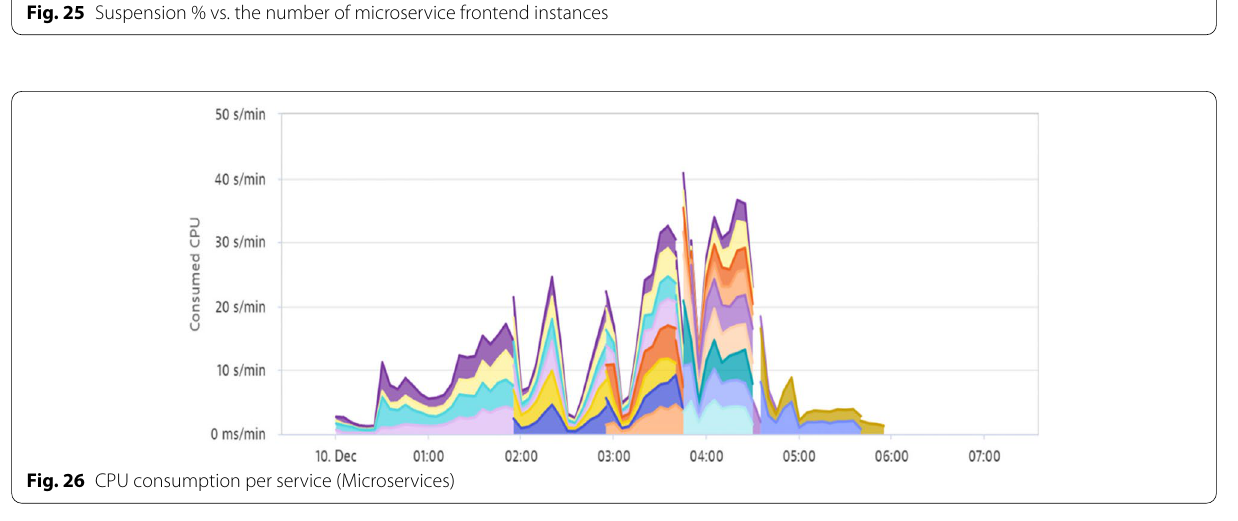
Fig. 26 CPU consumption per service (Microservices)